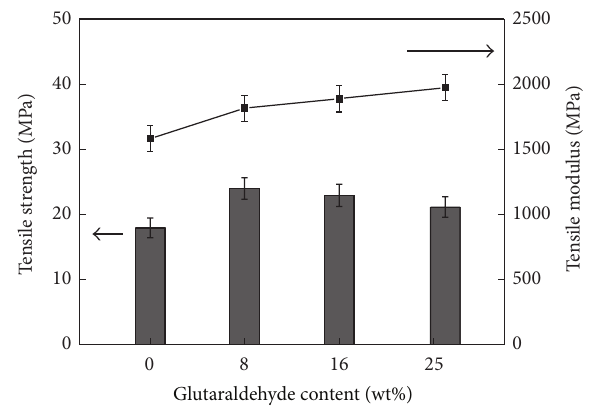
Figure 15: Tensile properties of the kenaf/SPI-PVA composites with GA content.